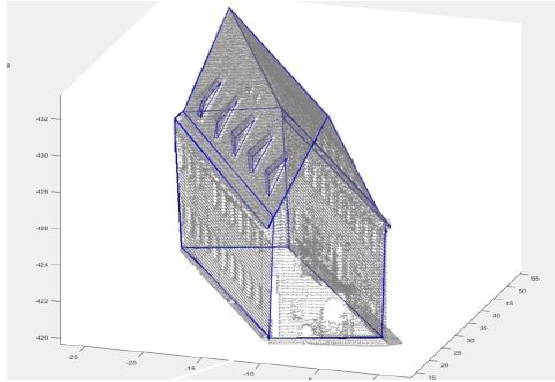
Figure 6. Building model with LoD3